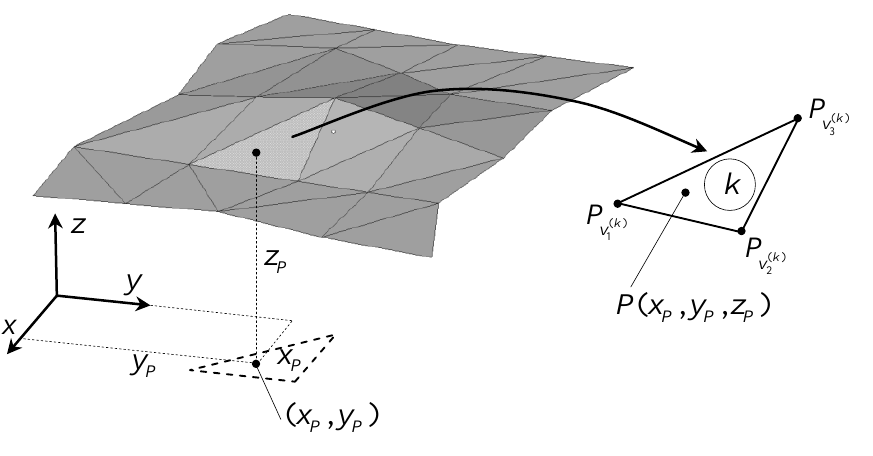
Figure 6. Searched point 𝑃 .